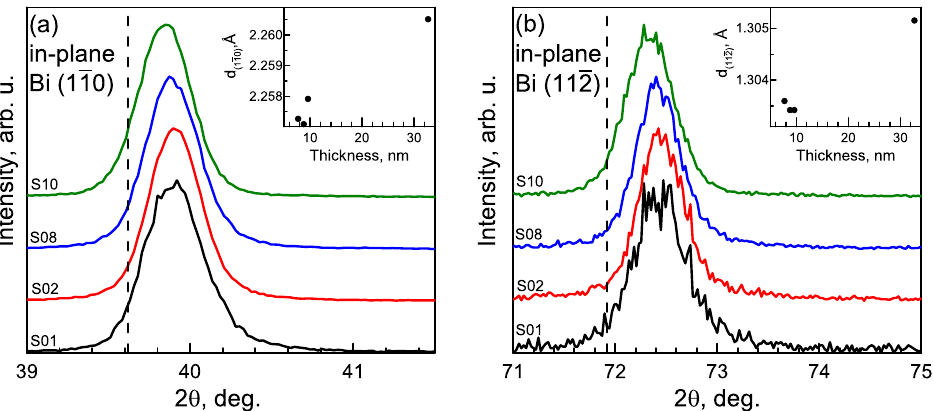
Figure 3. In-plane 2 θχ / φ measurements of (110) ( a ) and (112) ( b ) β -Bi planes. The vertical dashed lines show theoretical 2 θ values for the planes mentioned above. Interplanar spacing dependencies on the layer thickness are shown in the